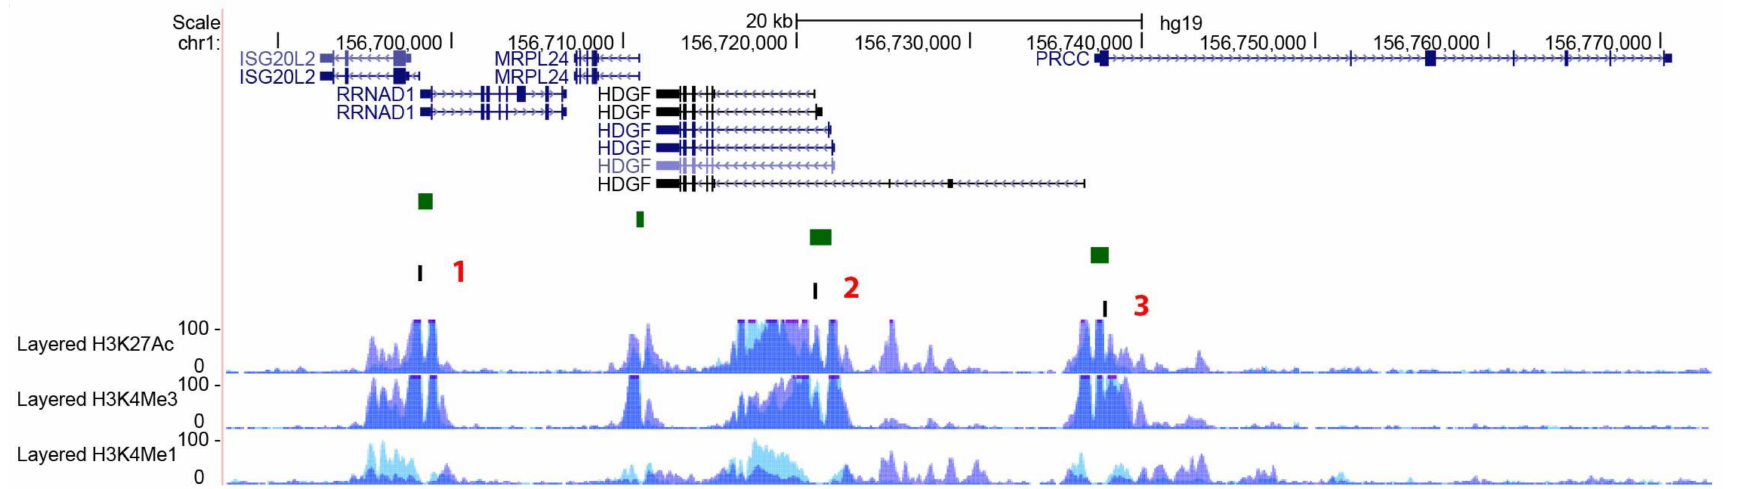
Figure 5. PEAR1 -interacting genes. Exons are depicted as black boxes, introns as black lines. 1, 2 and 3 in red indicate the regions analysed in the methylation study as described in material and methods and [53] to cover the ISG20L2/RRNAD1 , HDGF and PRCC CpG islands (depicted as green boxes). H3K4Me1, H3K4Me3 and H3K27Ac profiles are displayed as coloured overlaid histograms (light blue for HUVECs, purple for K562) in “auto-scale to data view” mode that takes the highest signal in the selected region as the 100% of the intensity and display all other signals accordingly (data produced by the Bernstein Lab at the Broad Institute and the UCSC and part of the ENCODE database). All regions included in the methylation study show high deposition of the enhancer specific histone marker H3K4Me1 and the promoter specific H3K4Me3. High peaks of the open active chromatin specific histone mark H3K27Ac are also visible in the same regions. Adapted from UCSC